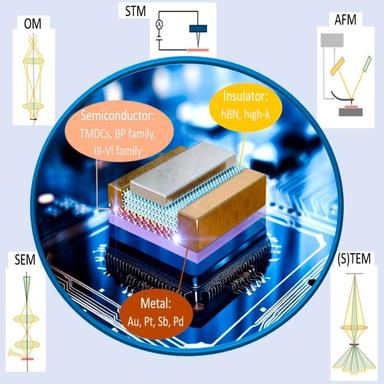
A typical 2D material-based transistor. Materials for various functions are marked at corresponding positions on the device model. A few common microscopy characterization techniques and schematic diagrams are displayed next to the transistor.